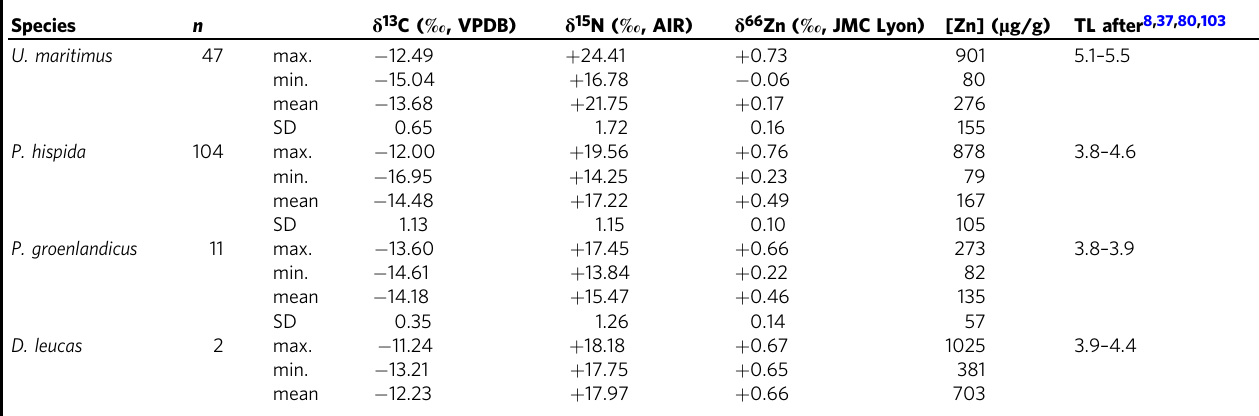
Table 1 Isotopic range ( δ 13 C, δ 15 N, δ 66 Zn) for all bone samples discussed in this study for which all three elements were